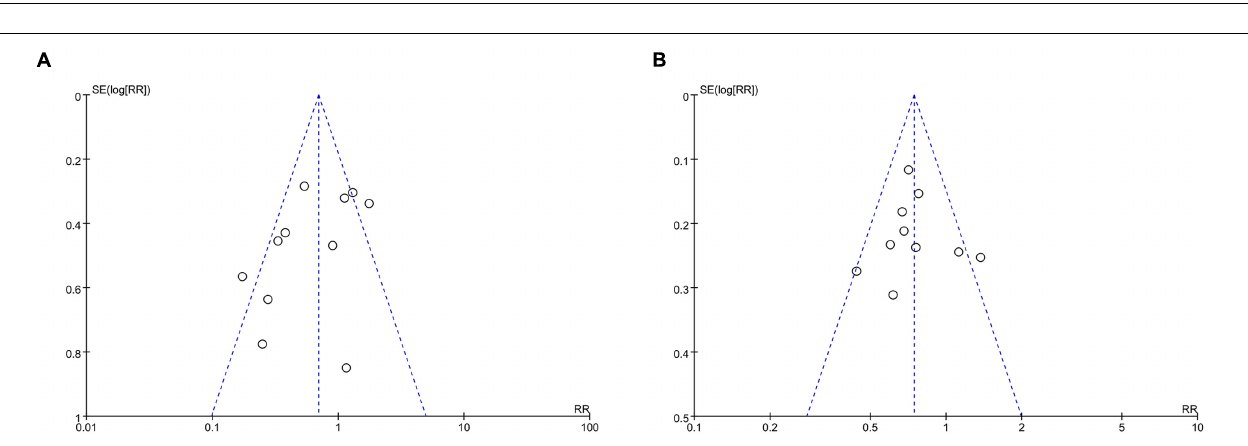
FIGURE 7 | Forest plot of RR of ERCP-induced hyperamylasemia SOM was administrated at high ( ≥ 3000 µ g) (A) and low dose ( < 3000 µ g) (B) . I 2 and P is the criterion of heterogeneity test, (cid:7) pooled risk ratio, — (cid:4) — risk ratio and 95% CI.